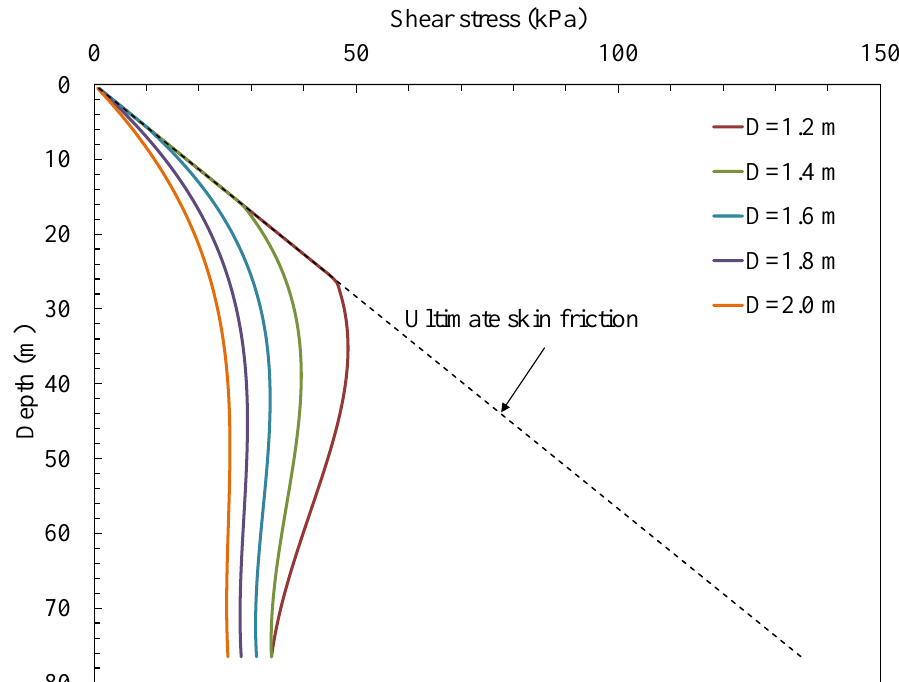
Figure 19. Effect of pile diameter on development of skin friction.